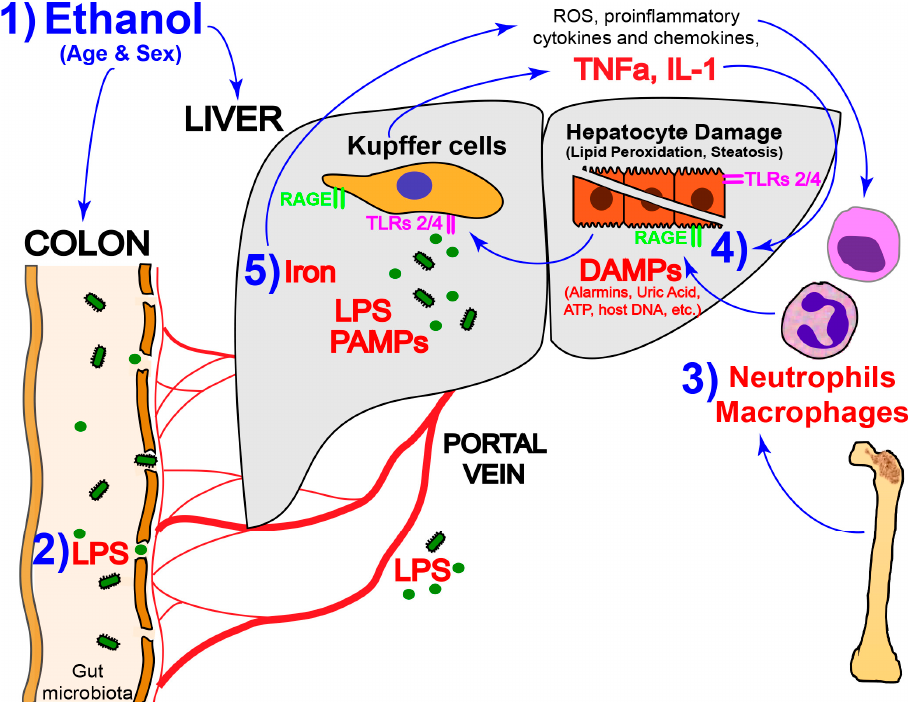
Figure 1. Key events contributing to the pathogenesis of alcoholic liver disease (ALD). (1) Aging and being a female enhance the vulnerability to ALD; (2) Lipopolysaccharide (LPS) translocation from the gut to the portal blood, which activates Kupffer cells (KC) to produce tumor necrosis factor α (TNF α ), interleukin (IL)-1 β and IL-18 via Toll-like receptors (TLRs) and other receptors still to be determined; (3) increased neutrophils and infiltration of bone marrow-derived macrophages that induce lipid peroxidation and hepatocyte steatosis, necrosis and apoptosis; (4) alcohol metabolism generates reduced nicotinamide adenine dinucleotide (NADH), which stimulates synthesis of excess fatty acids contributing to steatosis; and (5) iron deposition in the liver, which increases reactive oxygen species (ROS) production, leading to a proinflammatory microenvironment, therefore enhancing the severity of ALD. ATP: adenosine triphosphate; DAMPs: damage-associated molecular patterns; PAMPs: pathogen-associated molecular